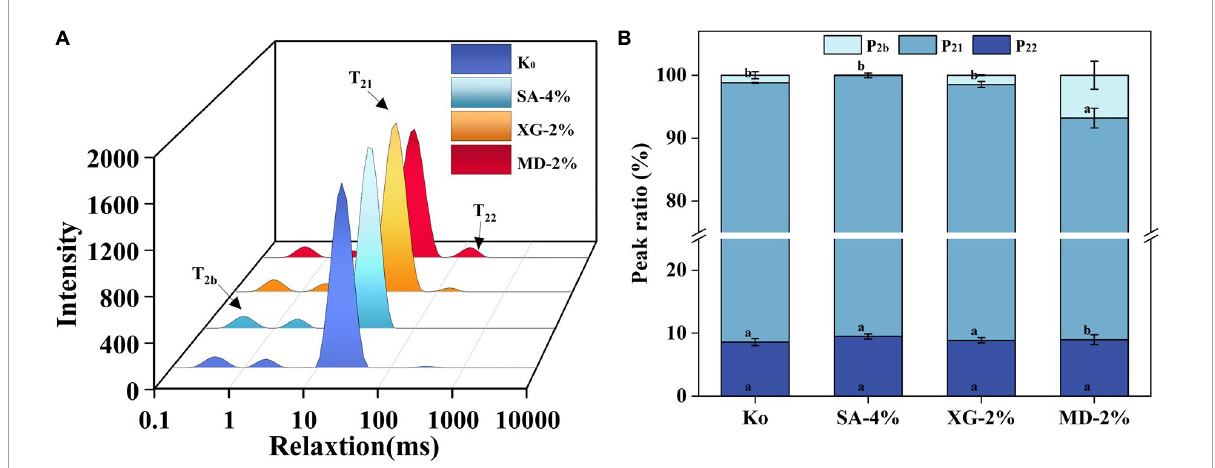
FIGURE3 Effect of different contents of sodium alginate (SA), xanthan gum (XG), and maltodextrin (MD) of the extrudates on (A) the transverse relaxation times